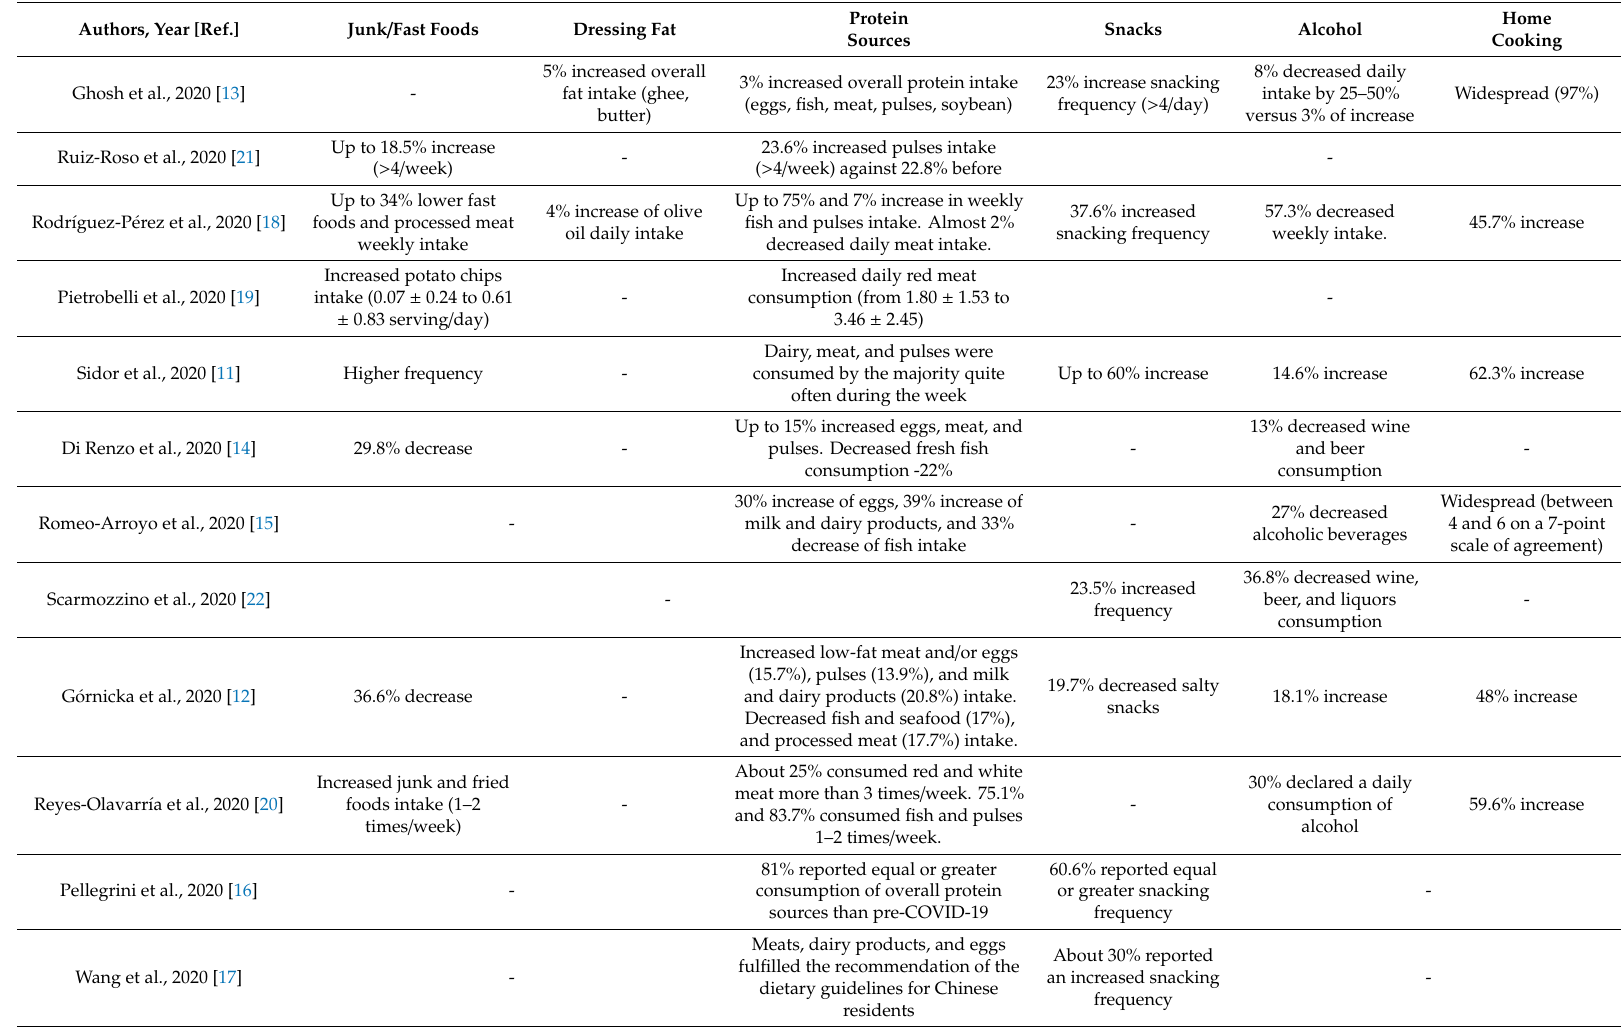
Table 4. Dietary characteristics of the study findings by other major principal food sources. Data on home-cooking habits were also included. Authors, Year